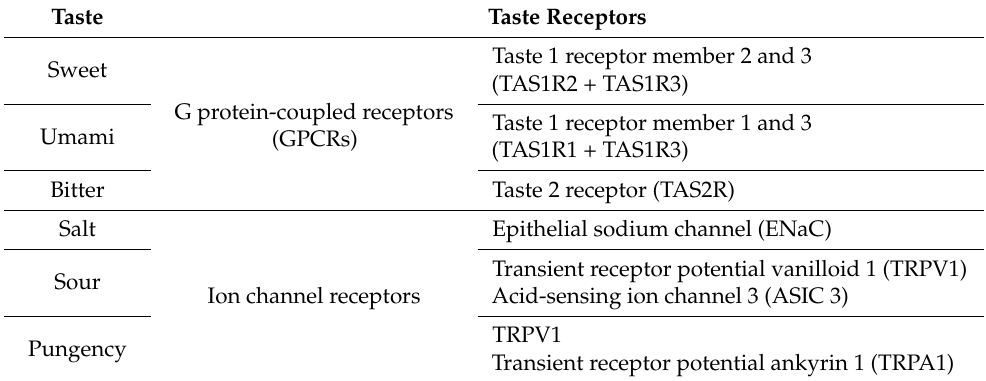
Table 1. The taste receptors that detect taste